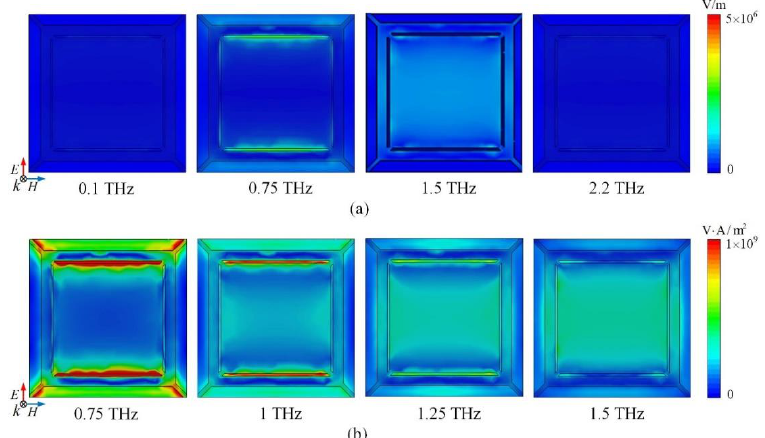
Figure 6. ( a ) The electric field distribution of the broadband absorption-controllable absorber at 0.1, 0.75, 1.5, 2.2 THz; ( b ) The power flow distribution of the broadband absorption-controllable absorber at 0.75, 1, 1.25, 1.5 THz.